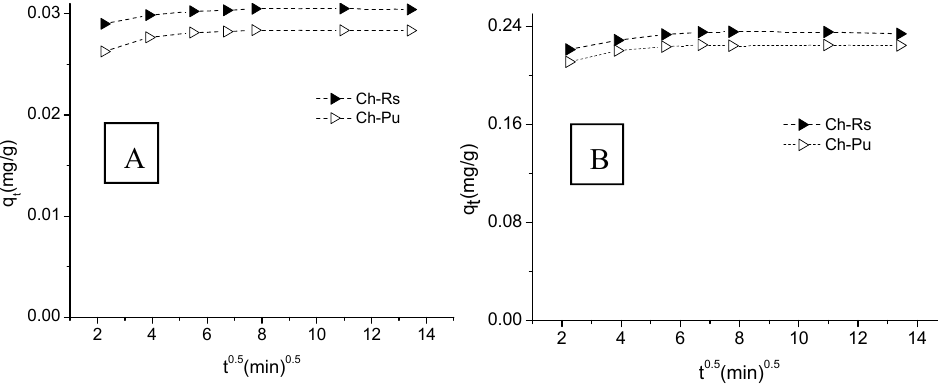
Figure 6. Intraparticle diffusion plots of As(V) adsorption on Ch–Rs and Ch–Pu blends at initial As(V) concentration of ( A ) 0.25 mg/L and ( B ) 2.0 mg/L.